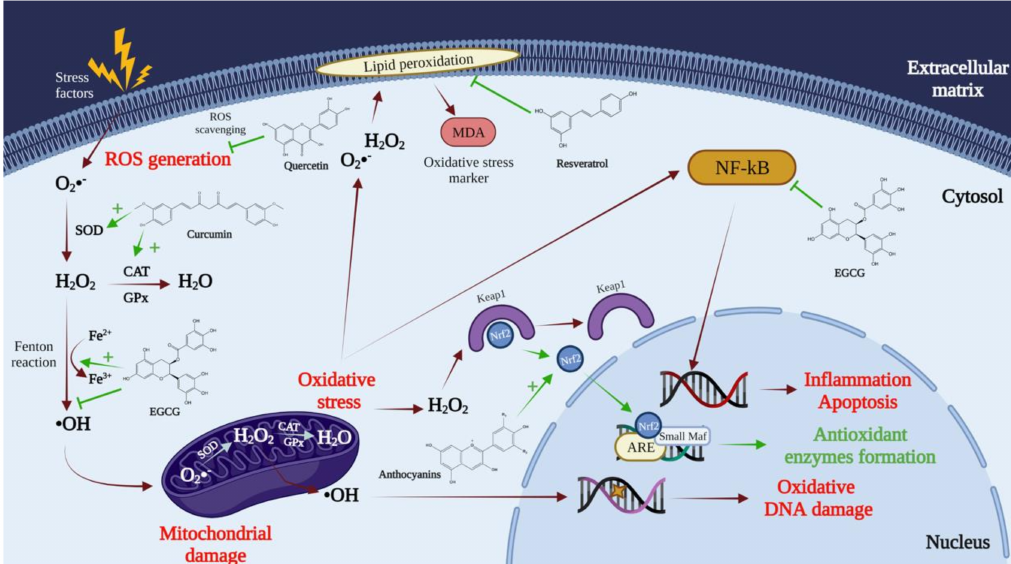
Figure 2. The mechanisms via which polyphenols act on free radicals, reducing oxidative stress. SOD, superoxide dismutase; CAT, catalase; GPx, glutathione peroxidase; MDA, malondialdehyde; Nrf2, nuclear factor erythroid 2-related factor 2; ARE, antioxidant response elements; Small Maf, musculoaponeurotic fibrosarcoma proteins; Keap1, Kelch-like ECH-associated protein 1; NF-kB, nuclear factor kappa-light-chain-enhancer of activated B